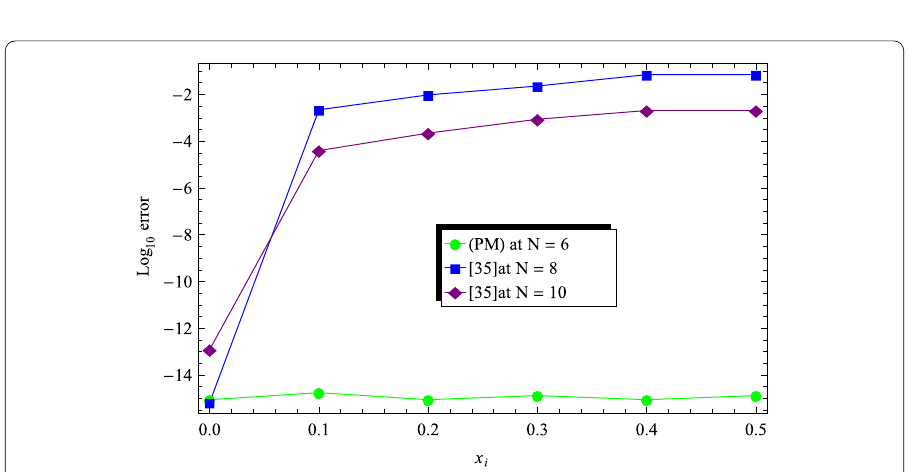
Figure 2 Comparison of y ( x ) for N = 10 with ν 2 = 2, 1.9, 1.8, and 1.7 for Example 4